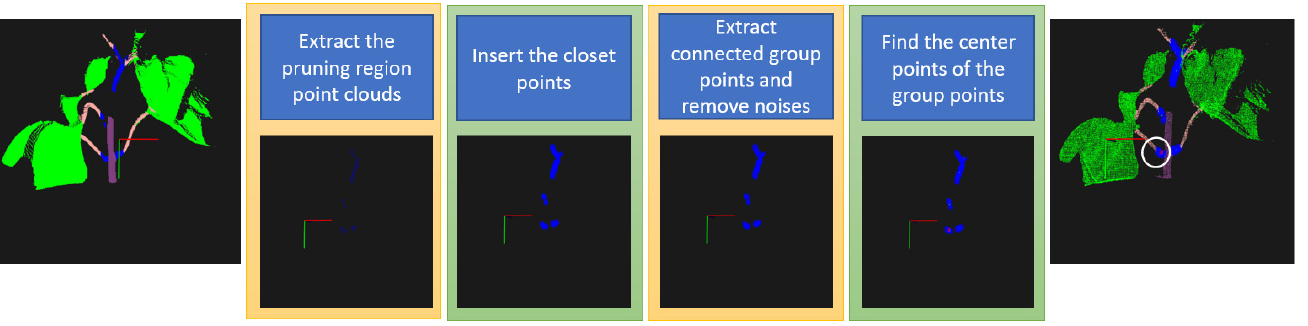
Figure 7. Four steps to detect the lowest pruning point in 3D space, and the red point is the final pruning point in the white circle. The red and green lines represent X and Y axes in a 3D coordinate system.